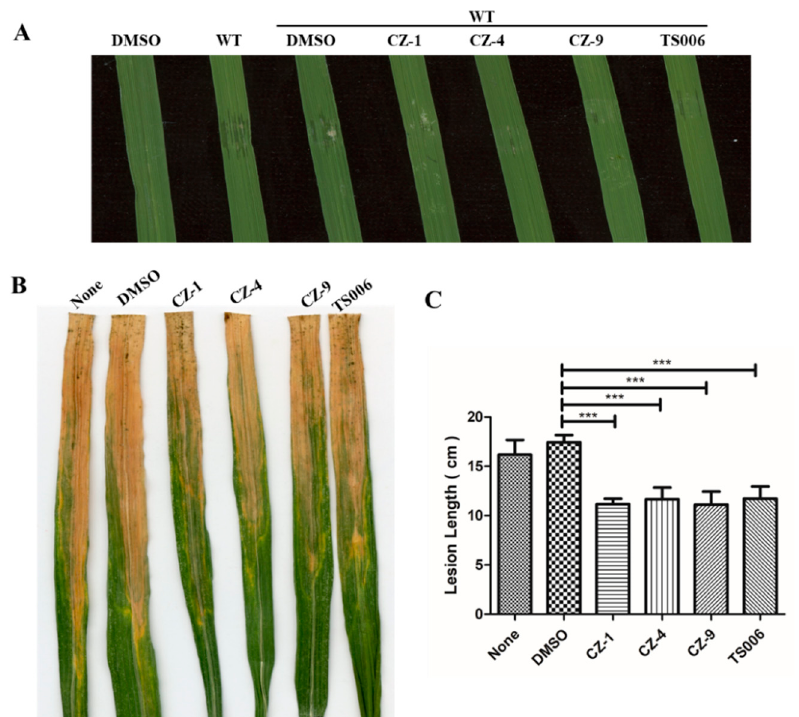
Figure 7. ( A ) The effect of CZ-1, CZ-4, CZ-9 and TS006 on water-soaking symptoms. From left to right, provide pure DMSO, WT, DMSO + WT, CZ-1, CZ-4, CZ-9 and TS006 ( B , C ) lesion lengths of Xoo PXO99 A on adult plants of rice cultivar IR24 were reduced after pretreatment with CZ-1, CZ-4, CZ-9 and TS006. Photographs were taken 14 days after infiltration. At least three independent tests were performed with similar results. Asterisks indicate statistically significant differences (Student’s t -test). *** p < 0.01.